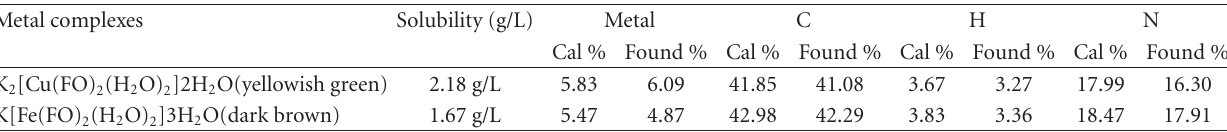
Table 1: Elemental analysis and solubility of the